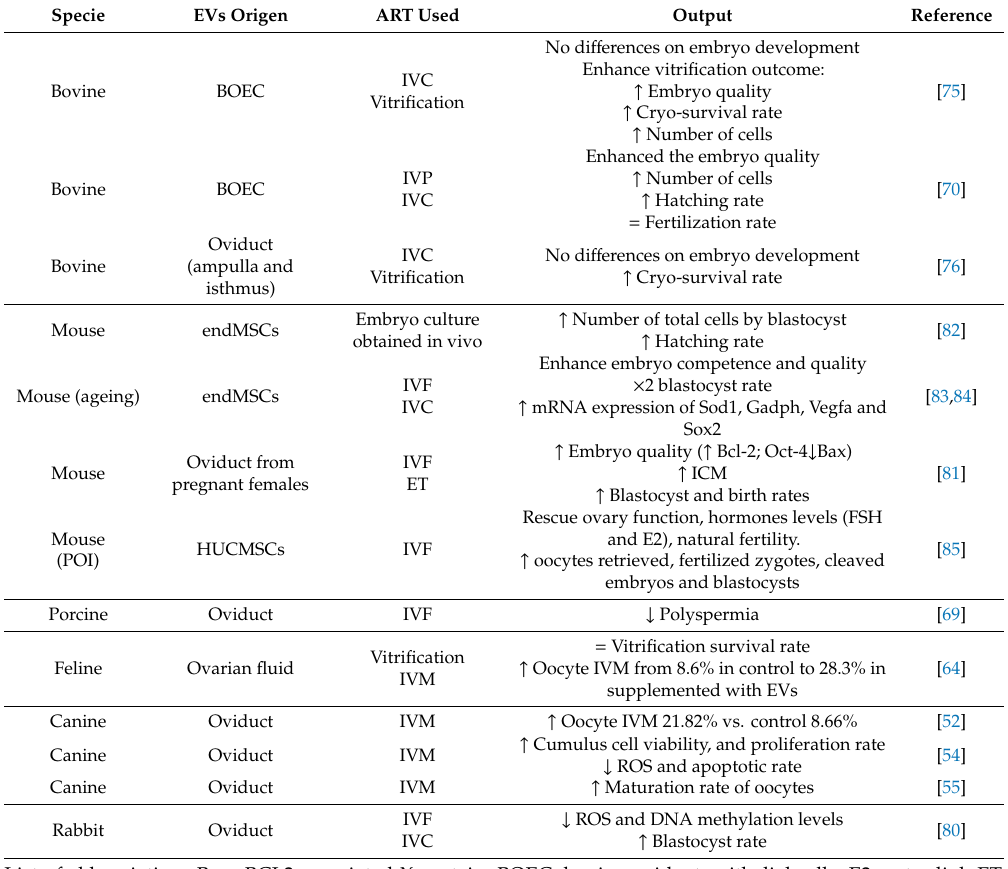
Table 3. E ff ects of co-incubation of extracellular vesicles and embryo on ART outcome. Specie